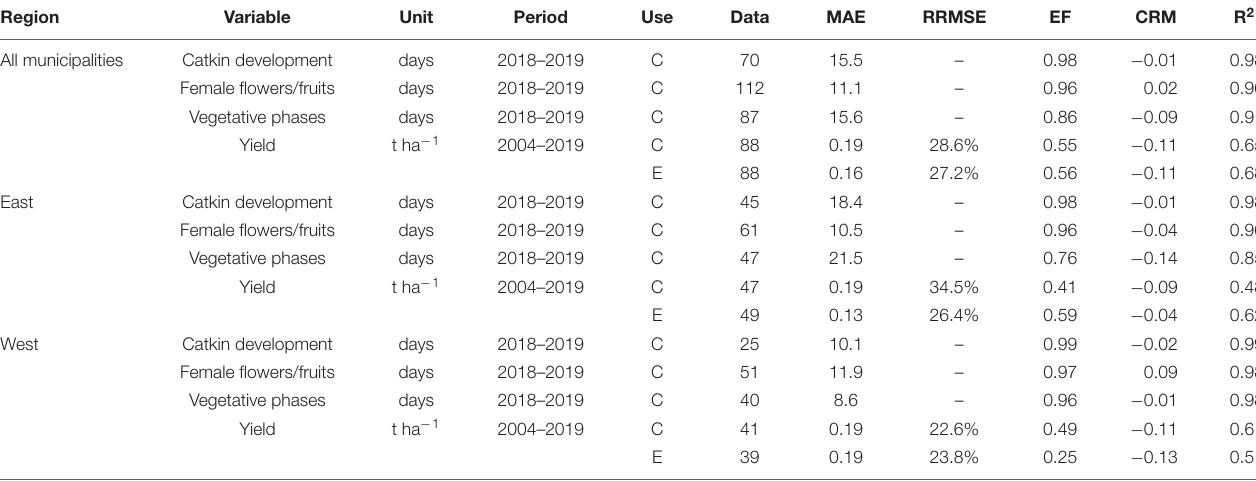
TABLE 1 | HAZEL model performance in reproducing hazelnut phenology, considering catkin development, female flowers/fruits ripening and vegetative phase and yield. Region Variable Unit Period Use